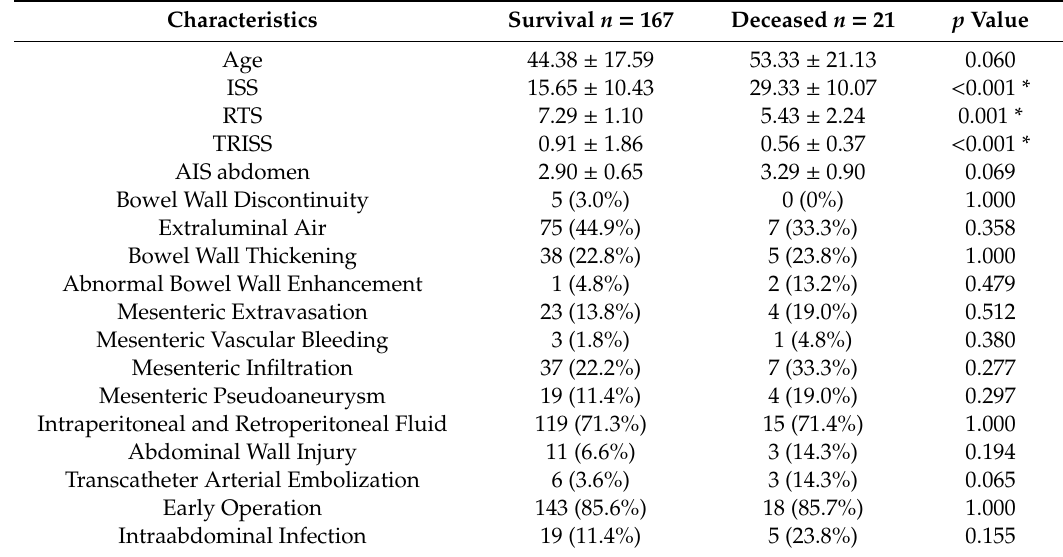
Table 3. The comparison between survival and deceased groups in blunt bowel and mesenteric